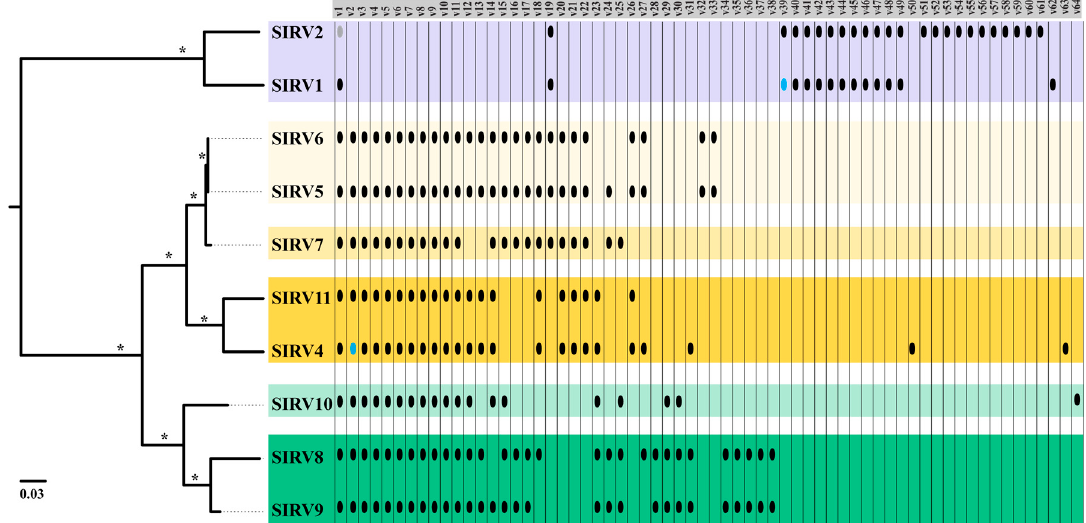
Figure 4. Presence/absence of variable genes in the different SIRVs. Colored boxes highlight strains by geographic location (yellow: Nymph lake, green: Norris Geyser Basin and blue: Iceland). Tree represents a Maximum Likelihood phylogeny of a concatenated nucleotide alignment of SIRV core genes. Asterisks (*) at branches indicate 100% bootstrap support as a percent of 1000 replicates. Scale bar represents substitutions per site. Grey dots represent sequence is present, but there is no start codon. Blue dots represent gene found in more than one copy.